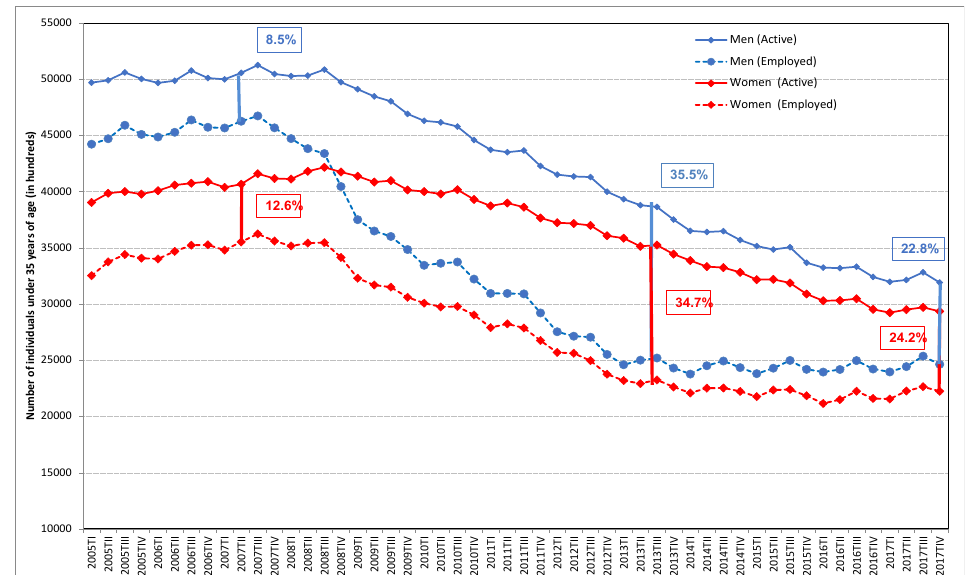
Figure 1 : Trends in activity and employment of young individuals (under 35) by gender, 2005-2017